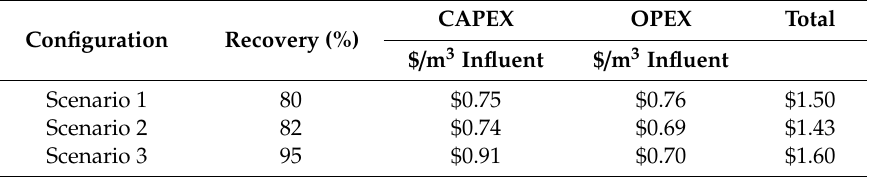
Table 10. Scale up normalized CAPEX and operating cost (OPEX) for each scenario.